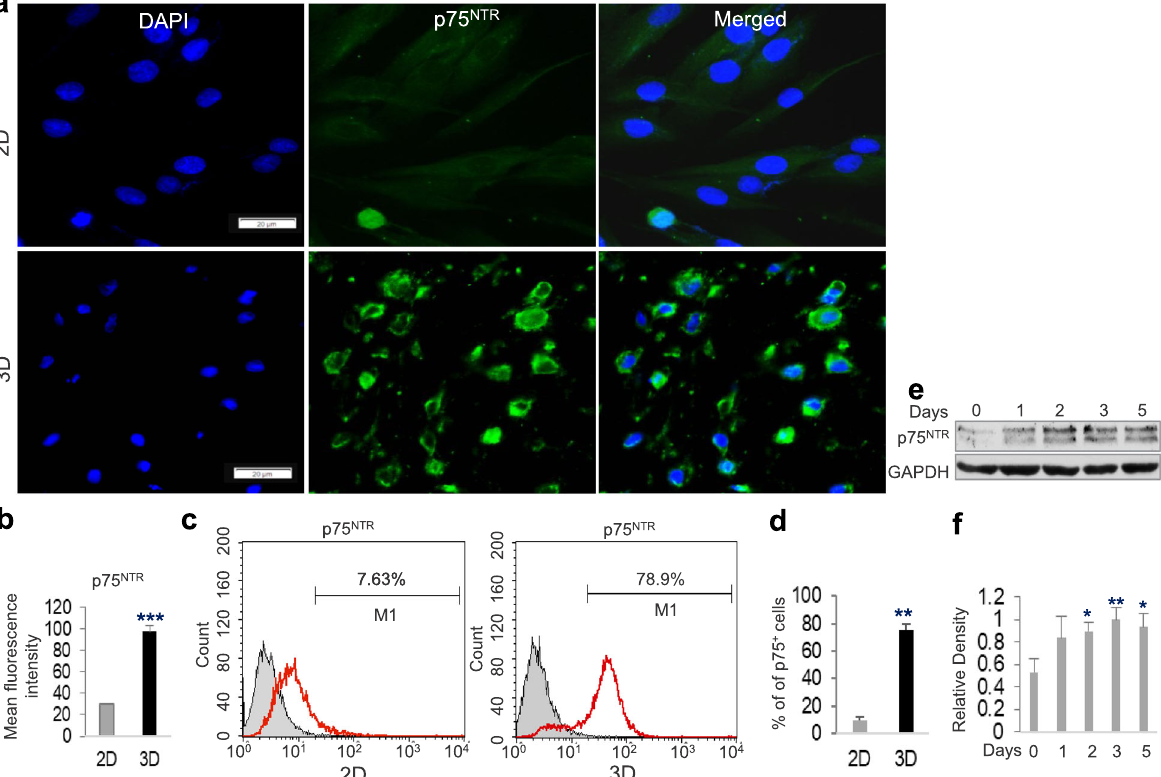
Fig. 2 Increased expression of p75 NTR protein in GMSCs cultured in methacrylated 3D-collagen hydrogel. GMSCs were cultured under 2D cultures or in 3D-collagen hydrogel (at 4 mg/ml) in complete α -MEM for 48 h. a Immuno fl uorescence staining against p75 NTR (green color), while nuclei were counterstained with 4 ′ , 6-diamidino-2-phenylindole (DAPI; blue). Scale bar = 20 µm. b Quanti fi cation of IF intensity of p75. c GMSCs were harvested from 2D-culture or recovered from 3D collagen hydrogel via digestion with collagenase I and then immuno fl uorescence staining for p75 NTR , followed by incubation with Alexa Fluor 488-conjugated secondary antibodies. The cell samples were analyzed by a fl ow cytometer (FCM). d The average of p75 + cells from FCM analysis. e GMSCs encapsulated 3D collagen hydrogel were cultured for different time periods and the expression of p75 NTR protein was determined by Western blot (WB). f Quanti fi cation of the relative WB density of p75 NTR with GAPDH as the internal control. Data represent the mean ± SD, n = 3 biological replicates. * p < 0.05; ** p < 0.01; *** p < 0.001; ns no signi fi cant; Student ’ s two- tailed unpaired t -test ( b , d, f ). 2D, GMSCs cultured in 2D-conditions; 3D, GMSC cultured in 3D-collagen